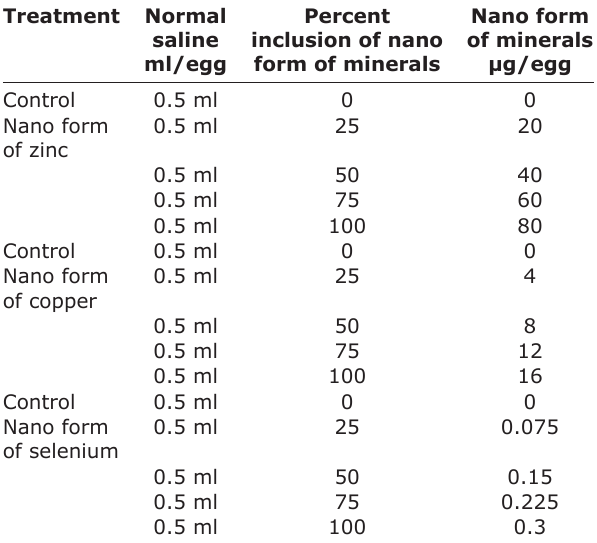
Table-1: Treatment groups experimented to assess optimum level of nano forms of zinc, copper and selenium required to be fed in ovo to fertile broiler